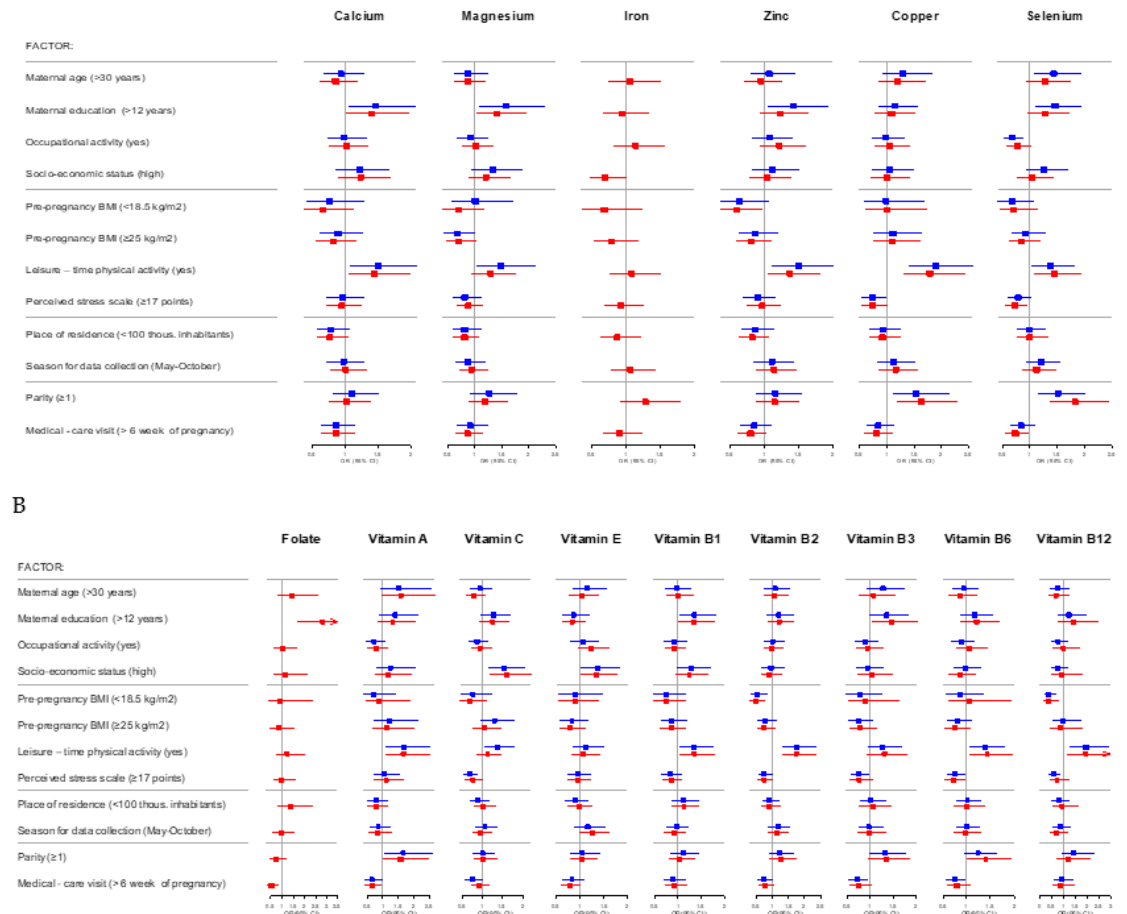
Figure 2. Adjusted effects of the explanatory factors for the adequacy of intake of selected essential elements (A) and vitamins (B) from dietary (blue) and total (dietary and supplementation) (red) sources, estimated by multivariable logistic regression models. For iron intake from dietary sources multivariable modelling was not feasible, because only 2 mothers attained recommended level. For folate intake from dietary sources multivariable modelling was not feasible, because only 6 mothers attained the recommended level. Reference groups: maternal age ≤ 30 years; maternal education ≤ 12 years; occupational activity between the 8th–12th weeks of pregnancy—no; SES—low/medium; pre-pregnancy BMI (kg/m 2 )— 18.5–24.99; LTPA—no; PSS < 17 points; place of residence (thousands of inhabitants) ≥ 100; season for data collection— November–April; parity—0; week of pregnancy of the 1st medical-care visit ≤ 6. 3.3. Factors Associated with Microelements and Vitamins Concentration in Blood Collected during Pregnancy The mean (±SD) microelements and vitamins concentration in blood (plasma) collected during the 1st trimester of pregnancy is presented in Table S9. Table S10 (the univariable linear regression model) and Table 1 (the multivariable linear regression model) show determinants of micronutrients and vitamins concentration in plasma. Based on the multivariable linear regression model, higher SES was a significant determinant of a higher Se concentration ( β = 3.1; 95%CI: 0.2–5.9) and BMI ≥ 25 kg/m 2 as well as multiparity of a higher Cu concentration ( β = 0.2; 95%CI: 0.03–0.4 and β = 0.2; 95%CI: 0.1– 0.4, respectively). Higher concentration of vitamin E was noted among the women older than 30 compared to those who were 30 or younger ( β = 1.5; 95%CI: 0.6–2.4).